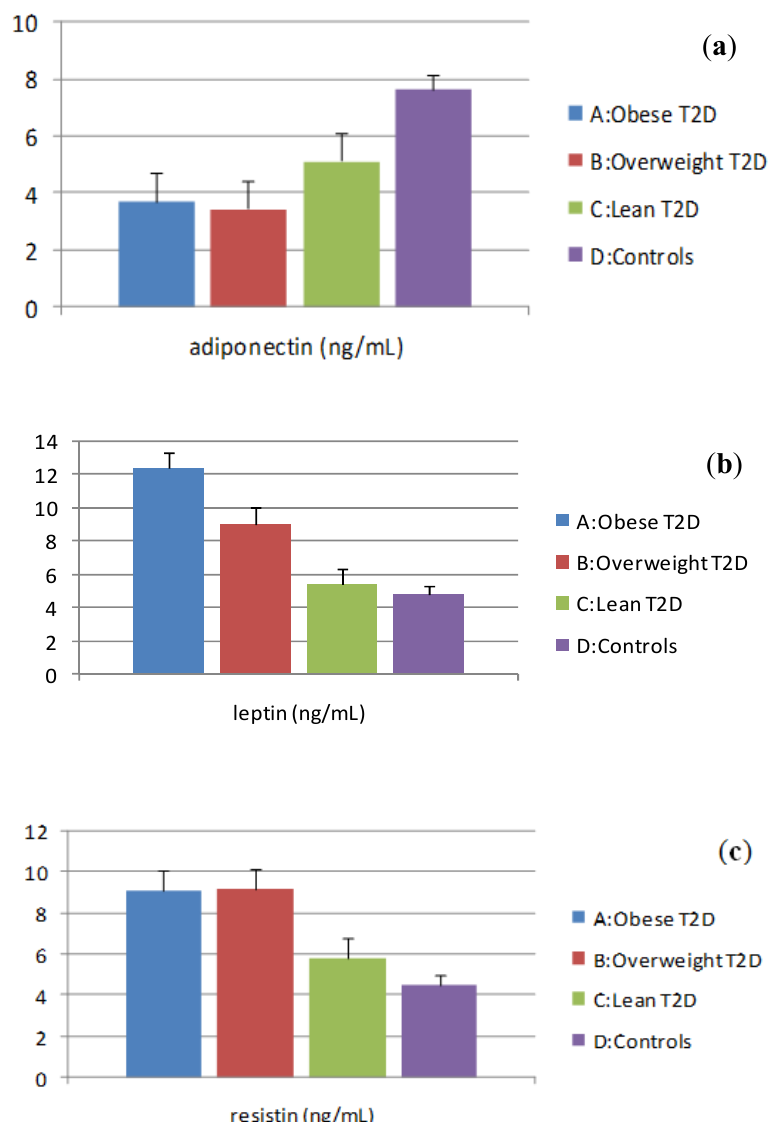
Figure 2. ( a ) Plasma levels of adiponectin; ( b ) Plasma levels of leptin; ( c ) Plasma levels of